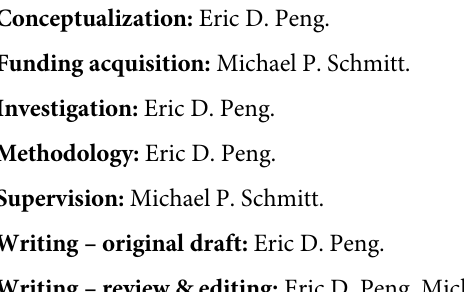
S1 Fig. Array correlation and complementation. (A) Selected genes were tested for expres- sion by RT-qPCR using the same RNA samples processed for the microarray comparing the wild type grown in media without and with zinc supplementation. (B) Log detected by RT-qPCR and microarray were compared with R 2 value indicated. S1 Table. Primers used for qPCR. S2 Table. Primers used for cloning. S3 Table. Primers used for